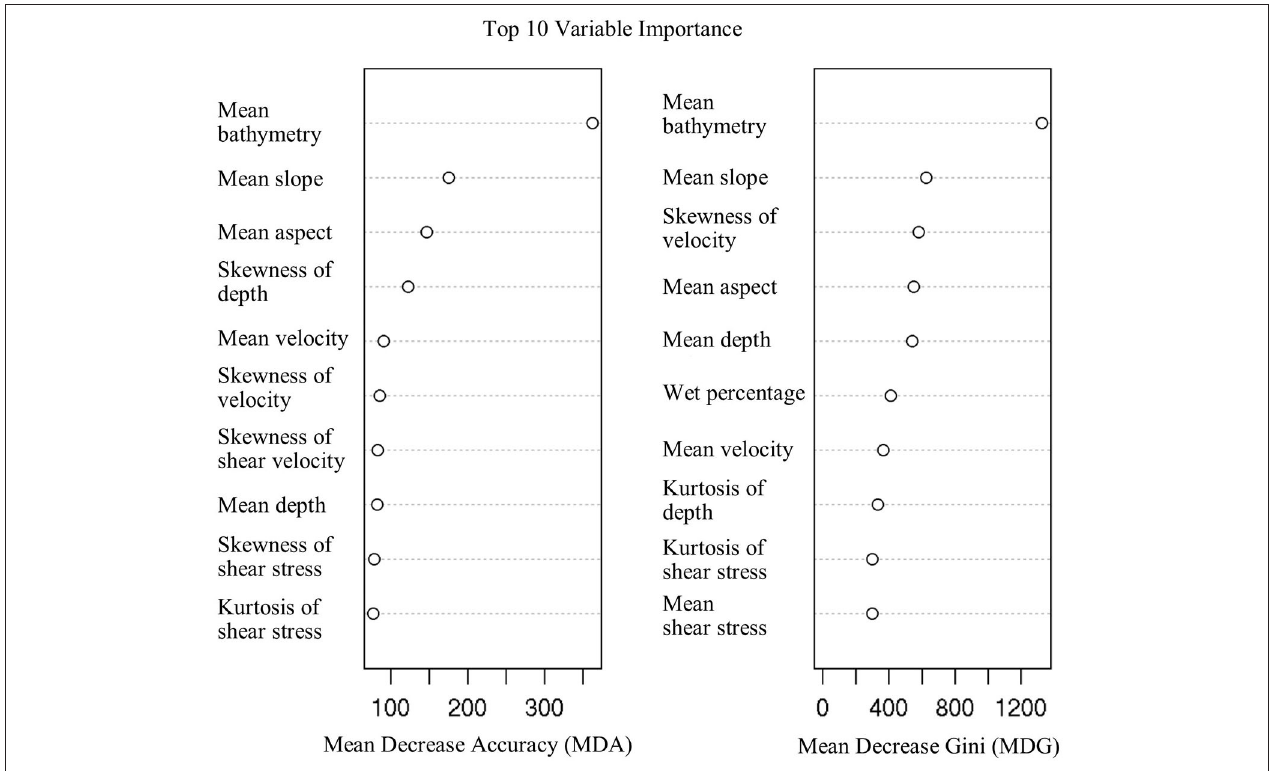
FIGURE 3 | Dot chart of the top 10 features importance as measured by the RF model trained in optimized configuration.